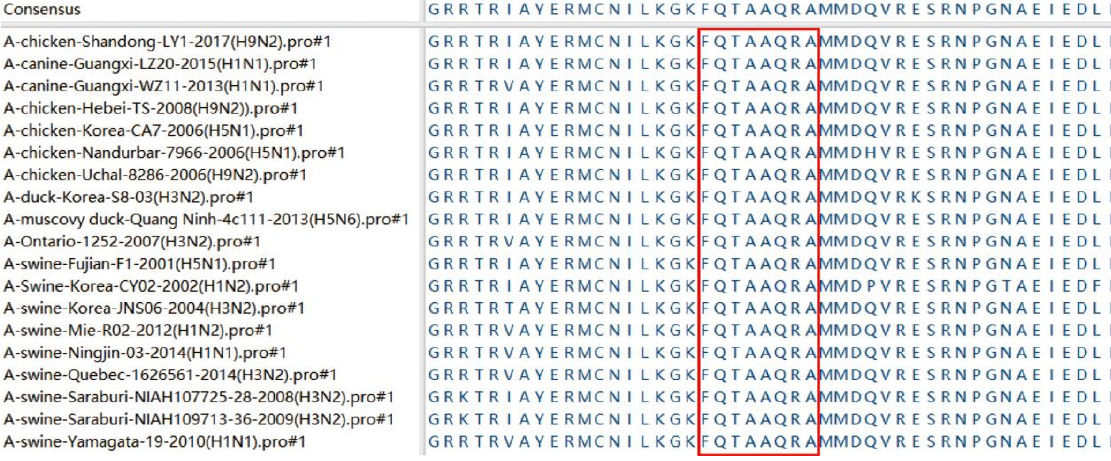
Figure 4. Antigenic epitope motifs were aligned with 18 AIV strains. The GenBank names of the AIV strains used are in parentheses. The homologous sequences of the identified antigenic epitopes corresponding to the different AIV strains are marked in a red box.